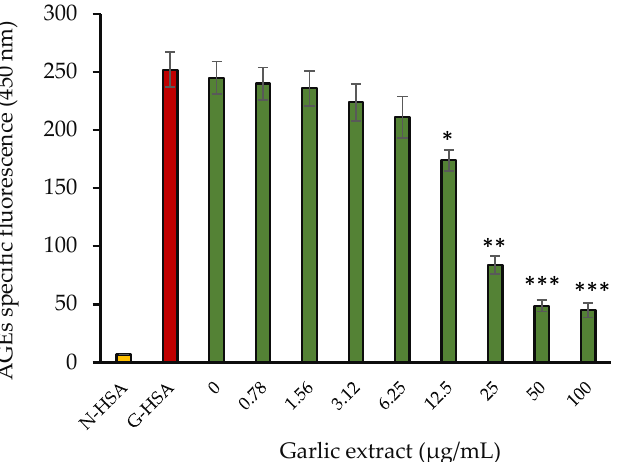
Figure 8. AGE-specific fluorescence intensity at 450 nm vs. concentration of garlic extract. Native HSA and G-HSA were incubated for 10 weeks as negative and positive controls, respectively. G-HSA was incubated with various concentrations (0–100 µg/mL) of garlic extract (green). The results are presented as means ± SEM ( n = 3). Reduction in AGE fluorescence results (0.78–100 µg/mL garlic extract) were compared with G-HSA sample. Comparison between two groups was performed based on t test, and significance was defined as * p < 0.05, ** p < 0.01, *** p < 0.001.